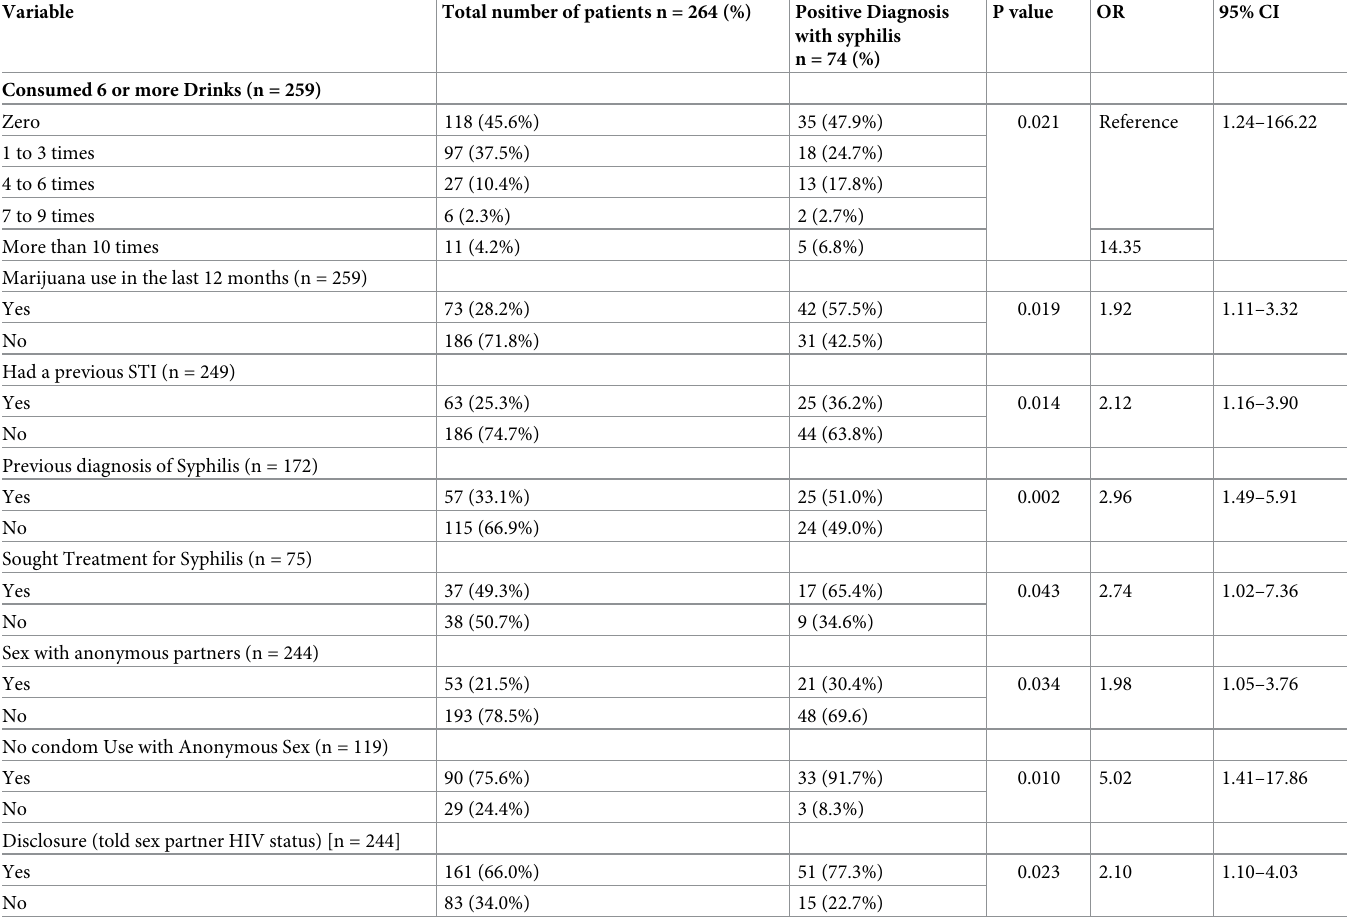
Table 2. Statistically significant correlates of prevalent syphilis in MSM living with HIV with a diagnosis of syphilis.